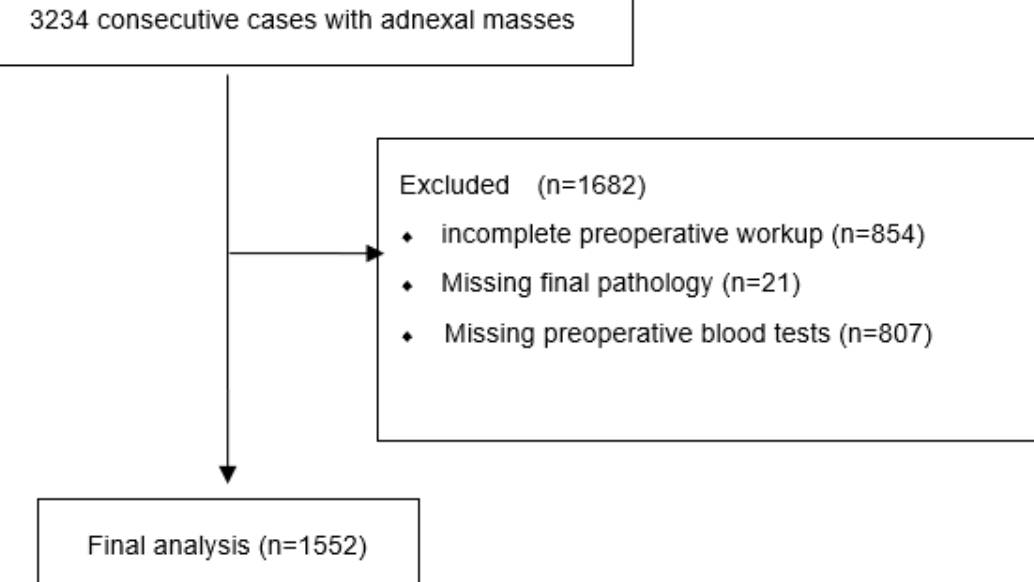
Figure 1 . CONSORT diagram describing the identification process and reasons for exclusion of the present retrospective analysis.